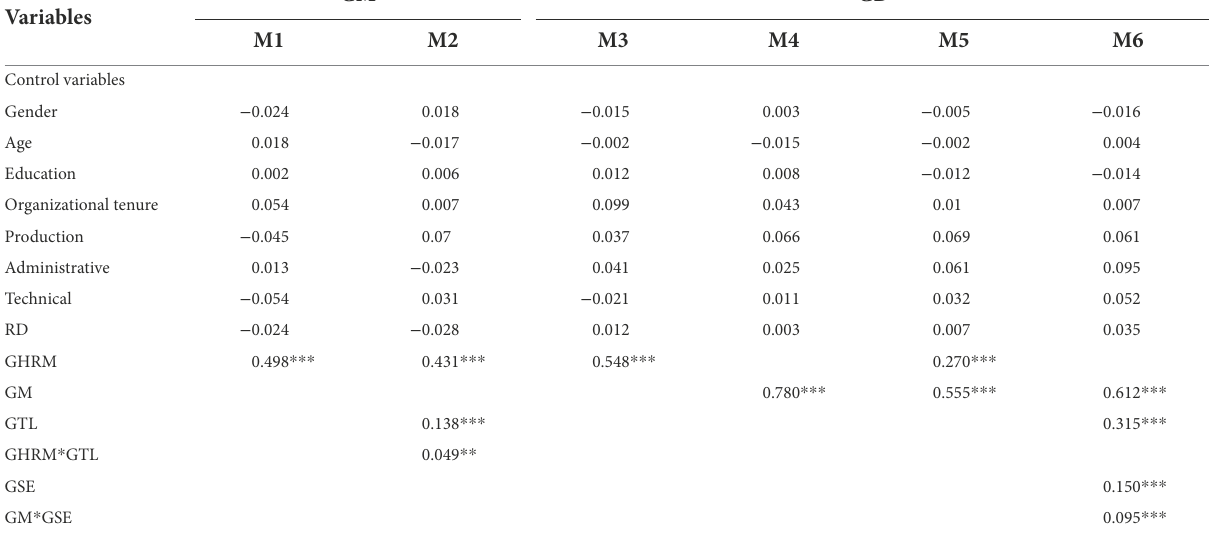
TABLE 4 Output of the hierarchical linear